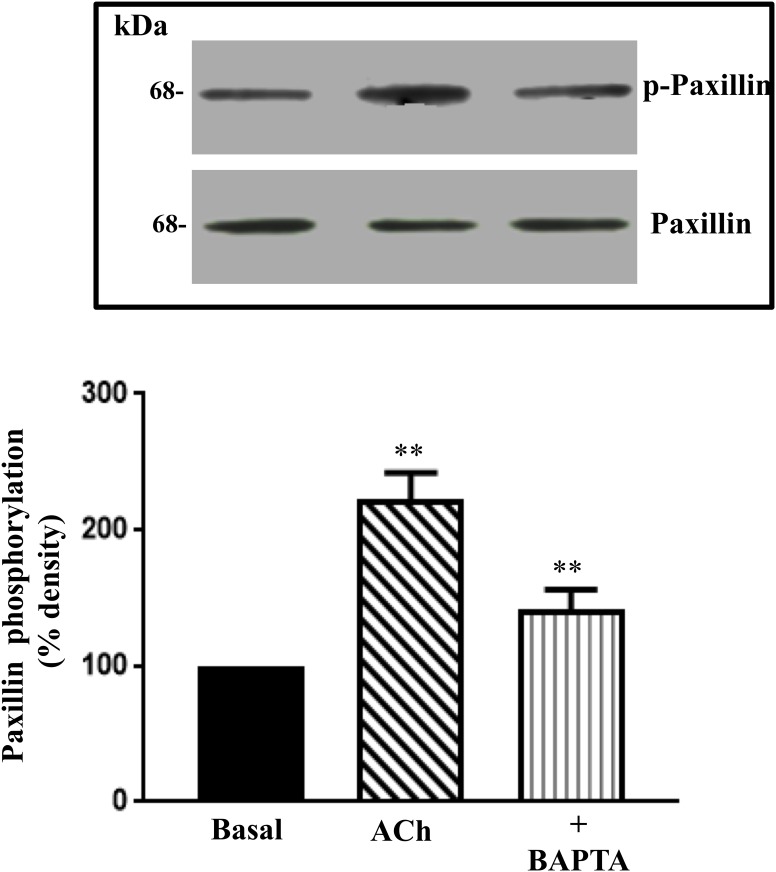
Ca2+ mediated paxillin phosphorylation by ACh.Immunoblots of paxillin and phospho paxillin from extracts of smooth muscle cells either unstimulated or stimulated with 1 μM ACh for 1 min in the presence or absence of Ca2+ chelator BAPTA (10 μM, 10 min). Phosphorylation of paxillin was measured using phospho-specific Tyr paxillin (Y118) antibody. The results are expressed as densitometric values. Values are means ± SE of three experiments. **P<0.001.